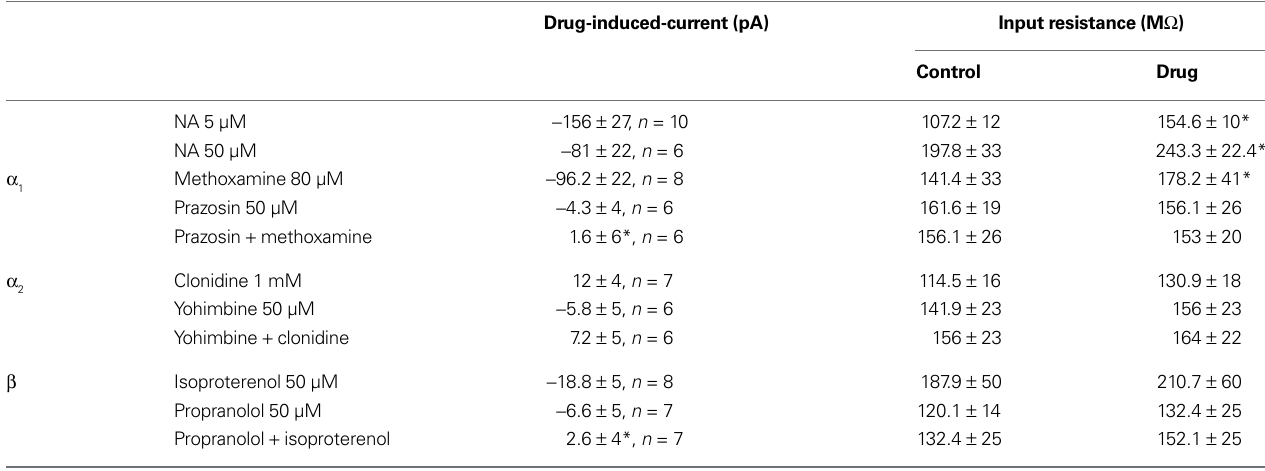
Table 1 | Mean current induced by the bath-application of the different noradrenergic compounds recorded from motoneurones held at − 75 mV and mean input resistance in control conditions and in the presence of the